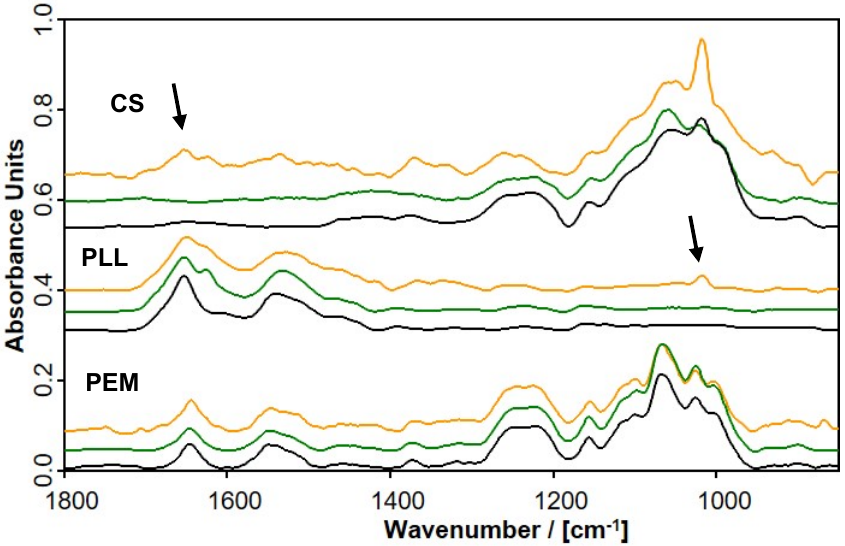
Figure 5. In situ ATR-FTIR spectra of PEM-20 films of PLL / CS (bottom) and ex situ ATR-FTIR spectra of dry films of the used PLL (middle) and CS solutions (top) at pH = 7.0 for c PEL = 0.01 M and c NaCl = 0 M (black), 0.1 M (green) and 1.0 M (orange) after consecutive adsorption at Ge IRE. For these PLL and CS solutions, 50 microliters of PLL and CS solutions, respectively, were spread onto a Ge IRE substrate. Note that the spectra of PEM-20 were scaled by a factor of 10 (0 M) and 15 (1.0 M), while the spectra of PLL and CS solutions were scaled by a factor of 4 and 10 for comparison purposes. Arrows indicate the diagnostic bands of the respective released guest component in the host PEL solution.